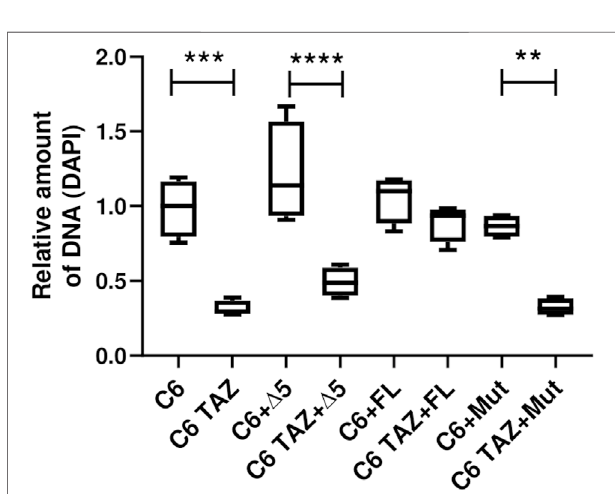
FIGURE7| Proliferation wascon fi rmed using DAPIstain. Density of800 C6 and C6 TAZ cells (w/o Δ 5, FL, Mut) were seeded in a 96 well plate. Cells were incubated for 96 h then fi xed with ethanol and later stained with DAPI (7.5 µM).Aftersubsequentwashingstepsthe fl uorescenceintensitywas measured at 450/570 nm wavelength. n = 4 biological replicates (C6 w/o Δ 5, FL and Mut) and n = 4 biological replicates (C6 TAZ w/o Δ 5, FL and Mut) is given as a boxplot with median, quartile and interquartile